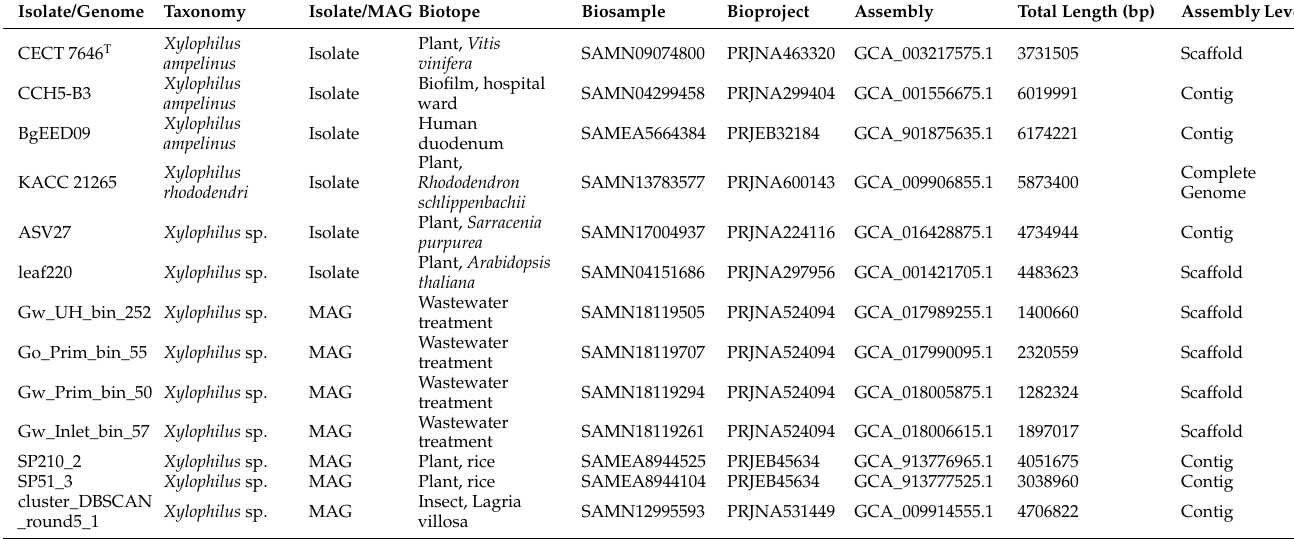
Table 1. Genomes available in GenBank on 1 June 2022 labeled as Xylophilus